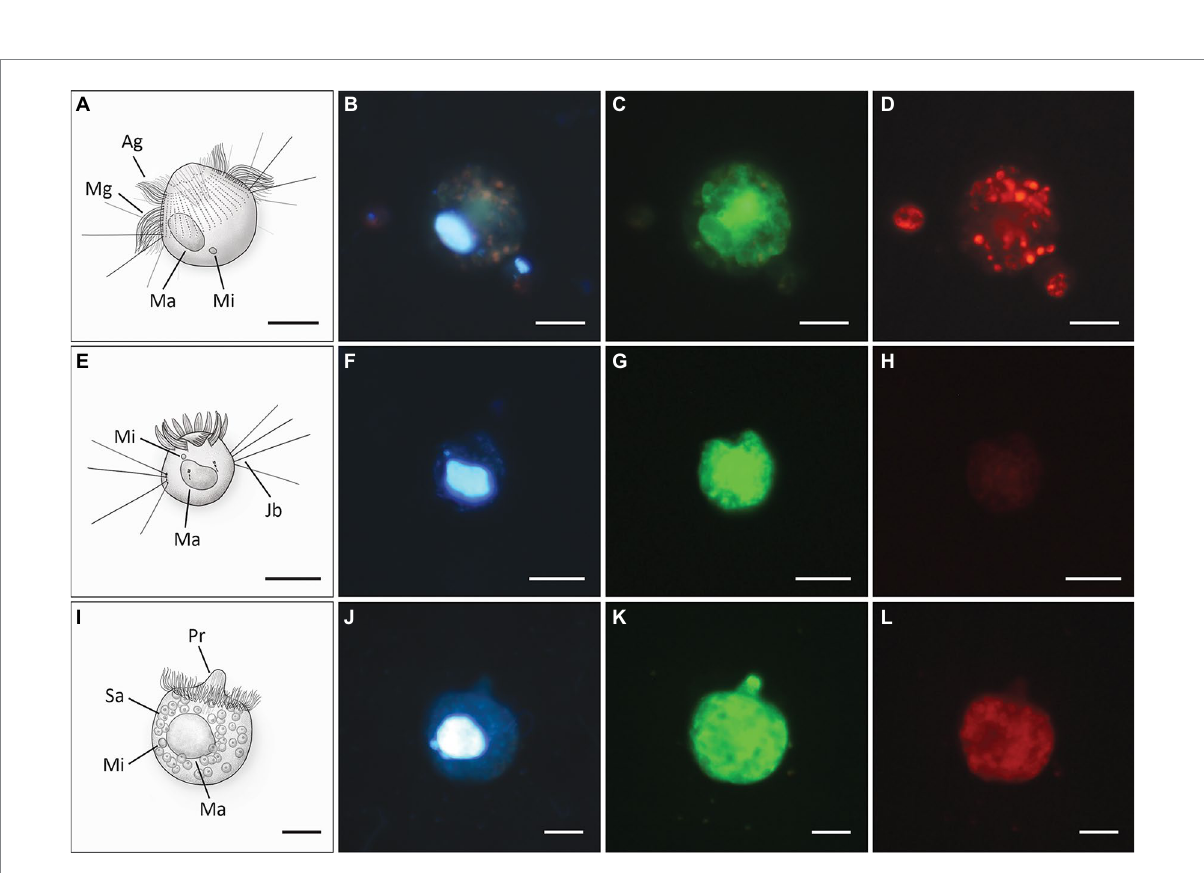
FIGURE 2 Drawings (first column) and associated photographs of CARD-FISH of A . cf. volvox (A–D) , H. grandinella (E–H) and M. chlorelligerum (I–L) . Photographs in each row show the same cell and were taken with an epifluorescence microscope using different optical filters to visualize macro- and micronucleus stained with DAPI (B, F, J) , cells hybridized with specific probes, i.e., A . cf. volvox with probe Ask-193 (C) , H. grandinella with probe Hal-all-1362 (G) , M. chlorelligerum with probe Mono-all-826 (K) , and autofluorescence of ingested Cryptomonas sp. (D) , algal endosymbionts of M. chlorelligerum (L) . (Ag) anterior girdle of ciliary tufts, (Jb) jumping bristles, (Ma) macronucleus, (Mg) middle girdle of ciliary tufts, (Mi) micronucleus, (Pr) proboscis, (Sa) symbiotic algae. Scale bars = 20 μ